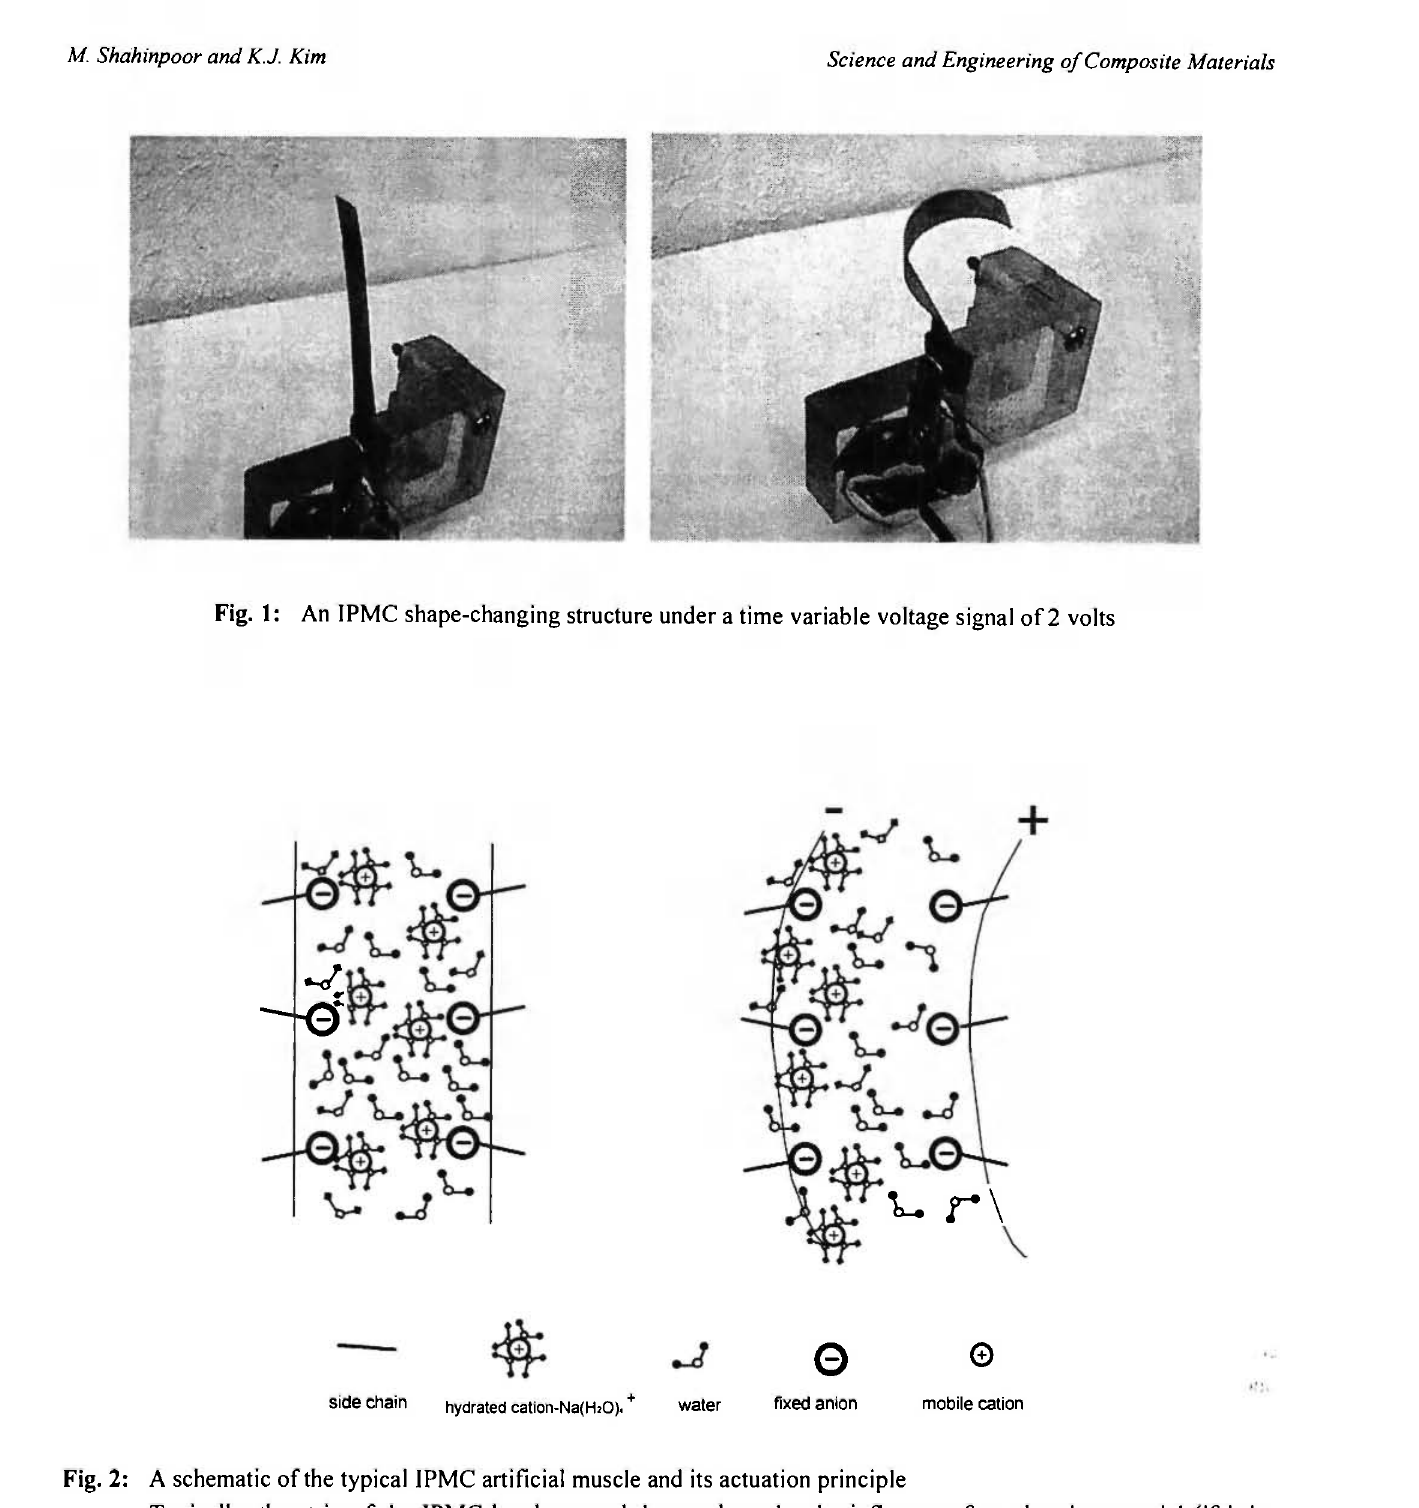
Fig. 2: A schematic of the typical IPMC artificial muscle and its actuation principle Typically, the strip of the IPMC bends toward the anode under the influence of an electric potential (if it is cation-exchange material), due to redistribution of cations and their hydrated water. The appearance of water on the surface of the expansion side and the disappearance of water on the contraction side occur near the